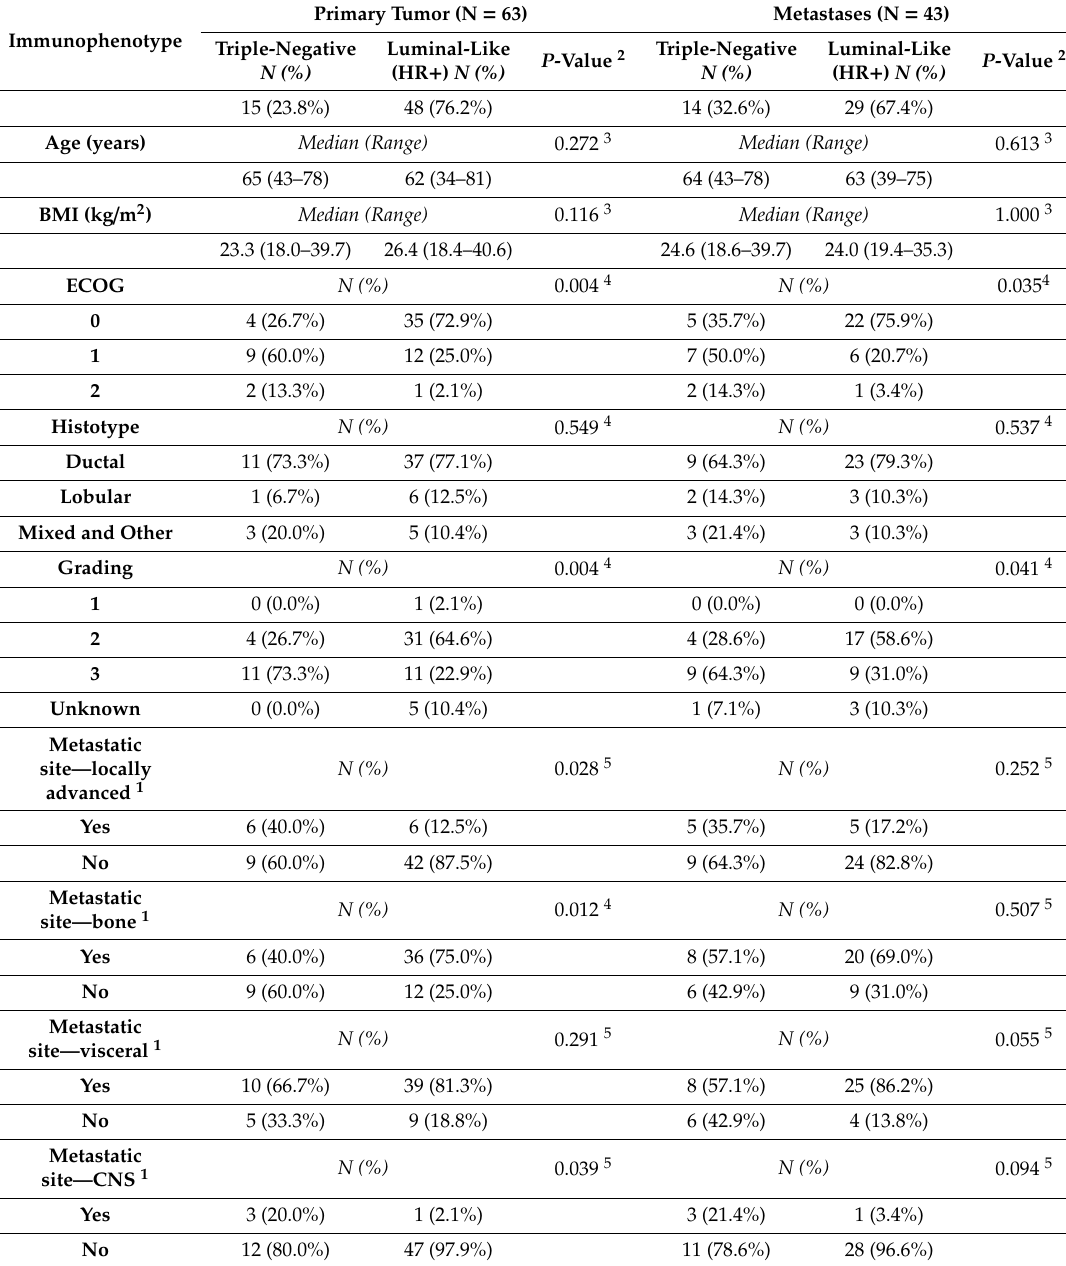
Table 1. Demographic and clinicopathological features of the analyzed MBC patients (N = 67) according to the HR status of the primary tumor (data available for 63 patients) and according to the HR status of metastases (data available for 43